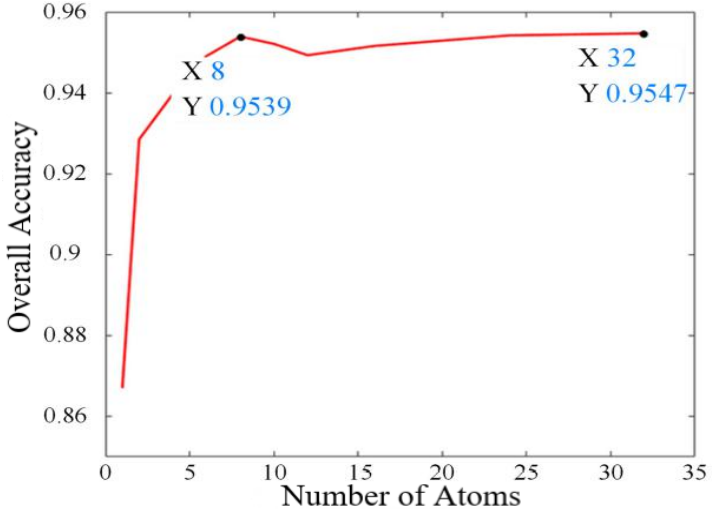
Figure 5. The classification OA under different numbers of atoms for each